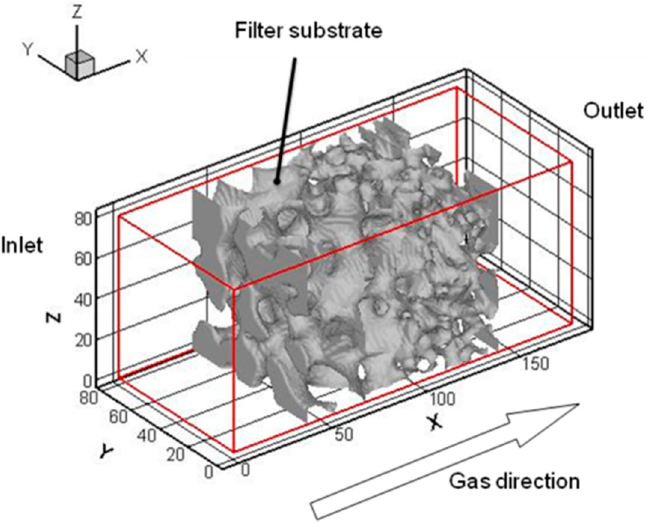
Figure 2. Calculation domain, showing the inner substrate structure of Filter 6.